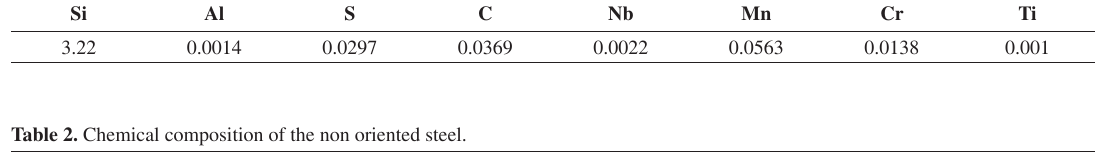
Table 1. Chemical composition of the grain oriented electrical steel. Si